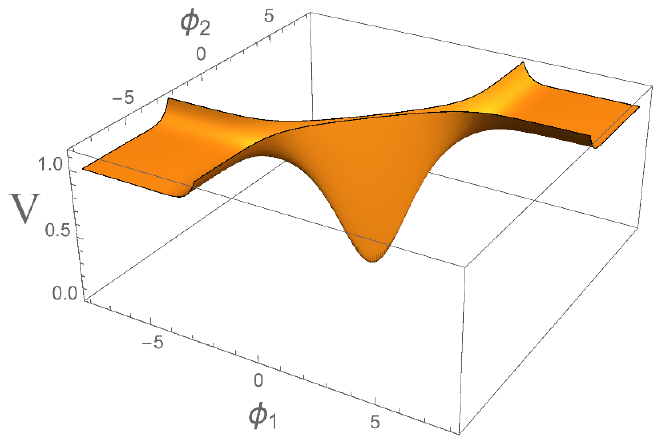
Figure 5 . Merger of two disks with (cid:11) = 1 = 3 creates the in(cid:13)aton T-model potential with (cid:11) = 2 = 3. In this (cid:12)gure we show the potential with M = 10 m